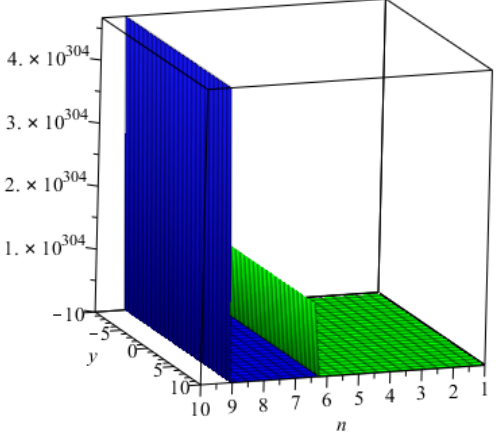
Figure 3. The graphical representation of the PM 1 ( G ) and PM 2 ( G ) indices.